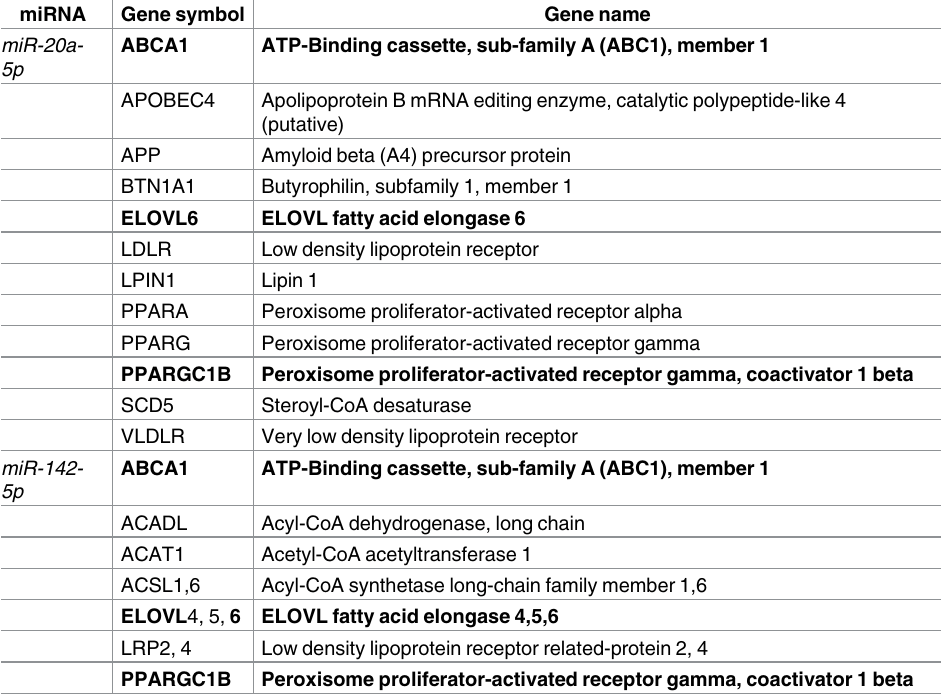
Table 2. Predicted targets of miR-20a-5p and miR-142-5p involved in the lipid metabolism. miRNA Gene symbol Gene